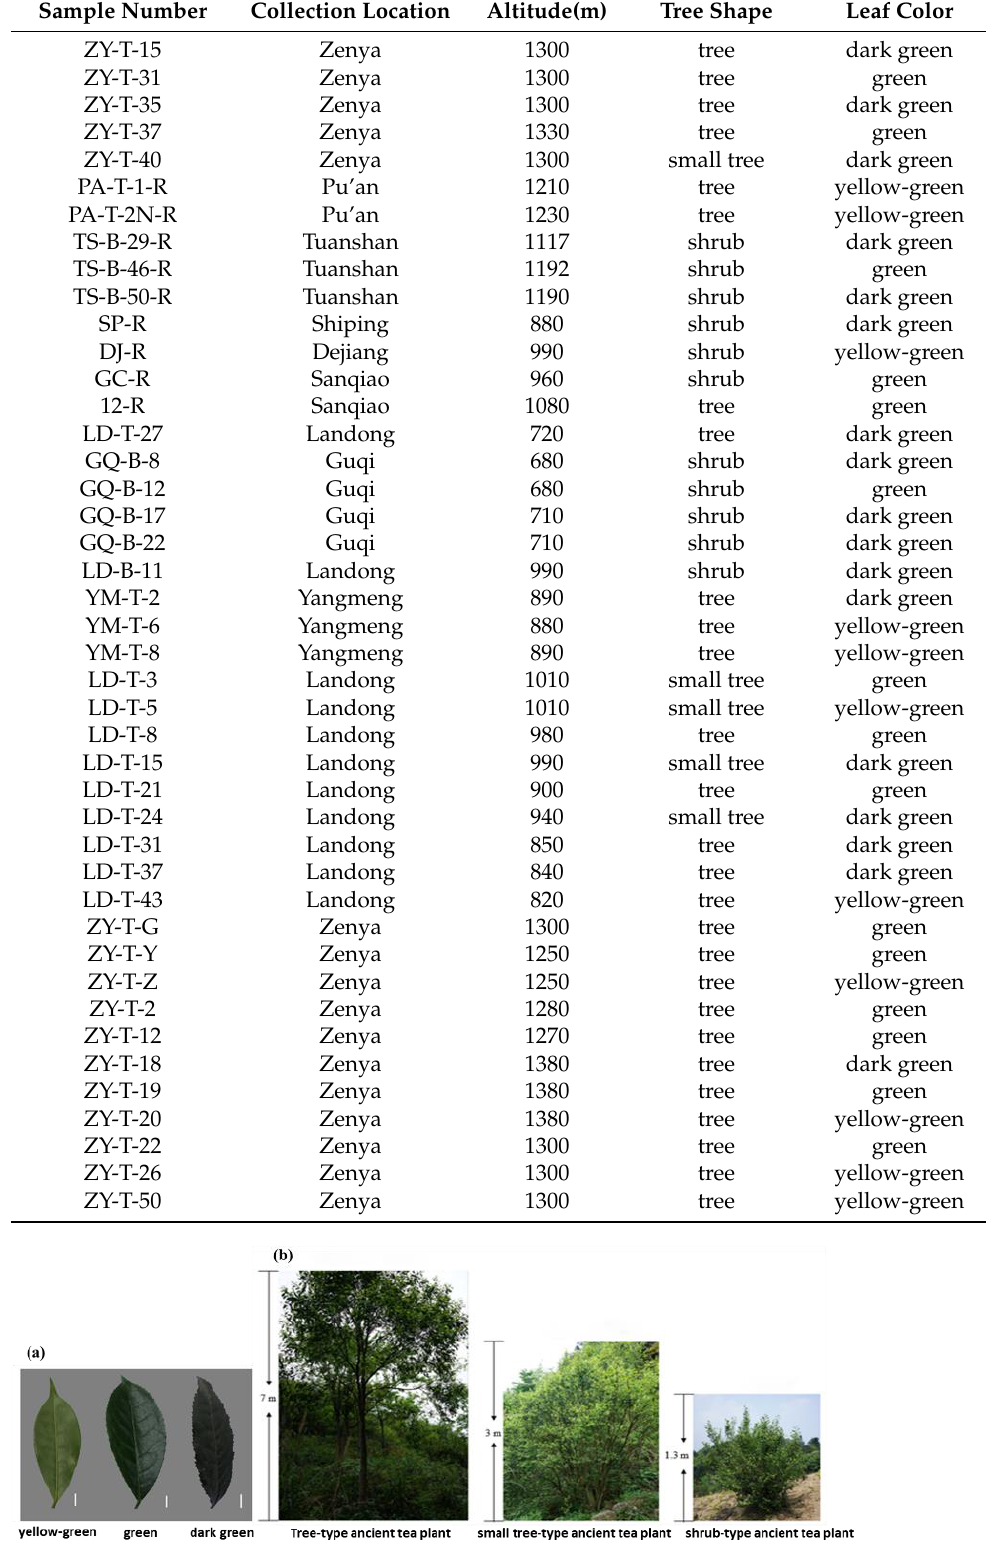
Table 1. Cont. Sample Number Collection Location Tree Shape